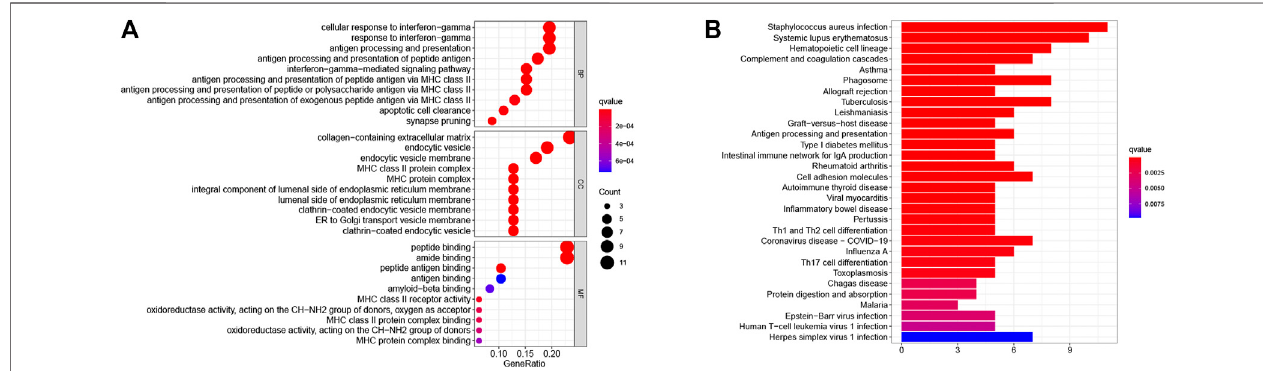
FIGURE 7 | Functional enrichment analysis of DEGs between the two pyroptosis-related subgroups. (A) GO enrichment analysis of DEGs based on PRS-score, including BP, CC, and MF. (B) KEGG pathway enrichment analysis of DEGs based on PRS-score. GO, Gene Ontology; KEGG, Kyoto Encyclopedia of Genes and Genomes; BP, biological processes; CC, cell component; MF, molecular